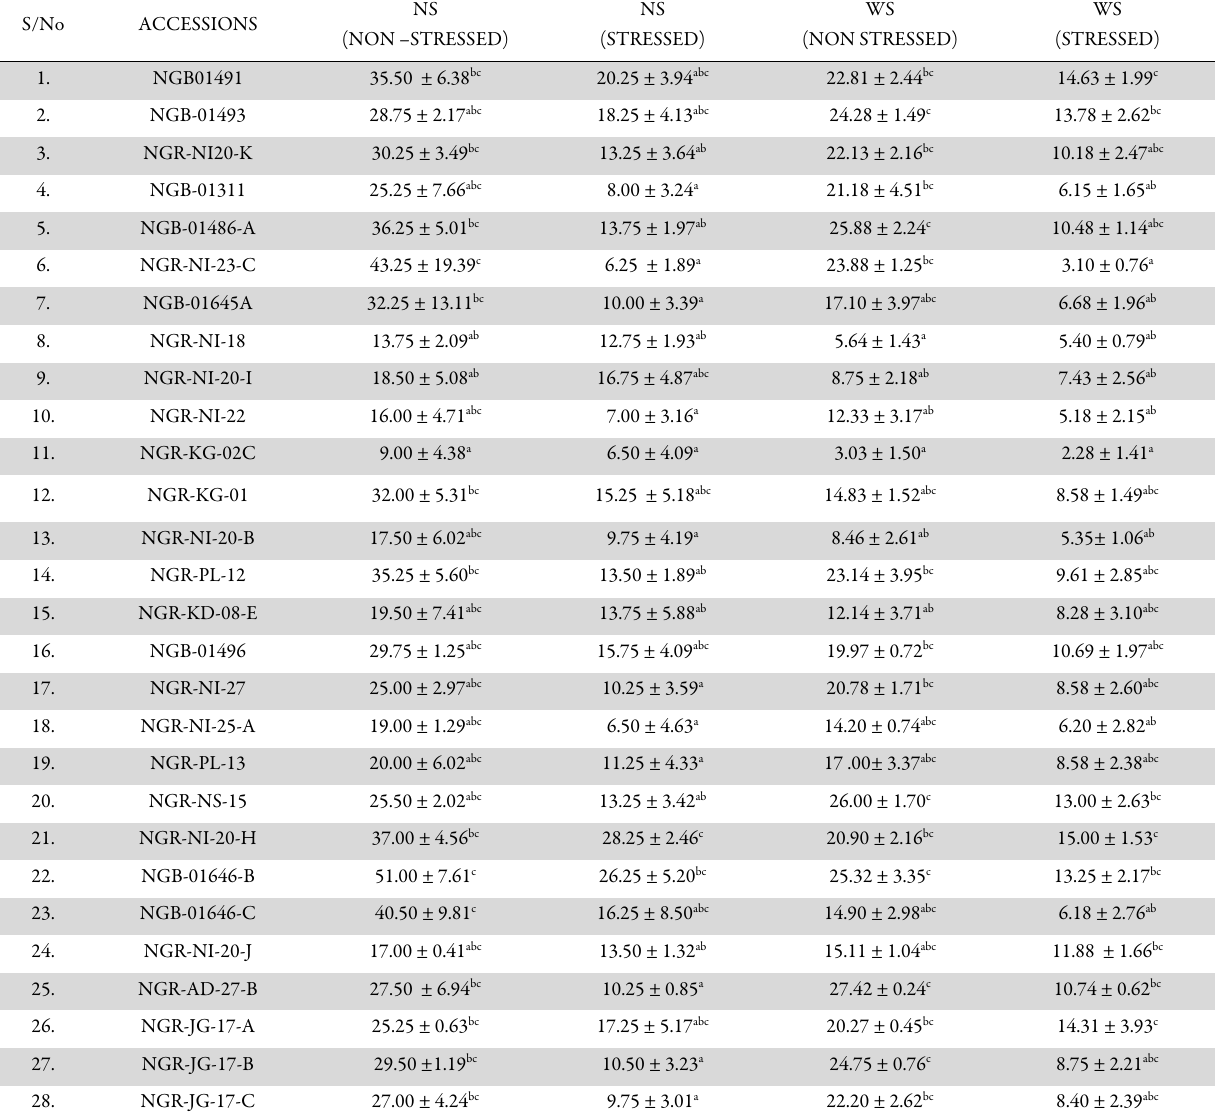
Table 2. Number of seeds and weight of seeds produced by Bambara groundnut accessions in Non- water stressed and stressed conditions